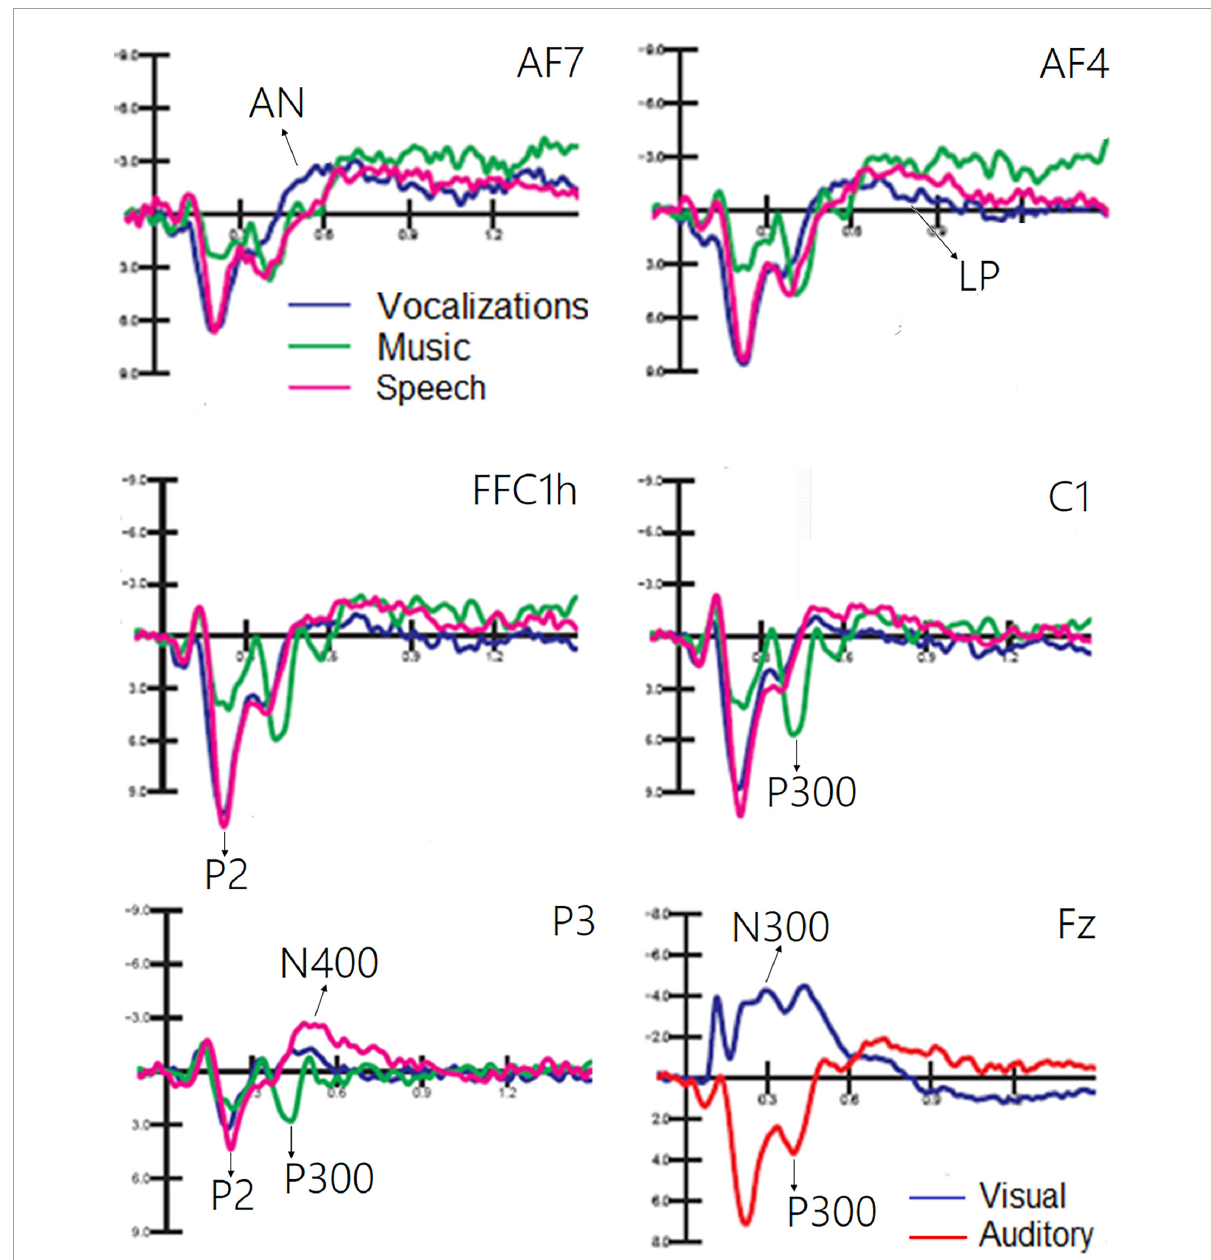
FIGURE6 Grand average ERP waveforms relative to the auditory processing of vocalizations, music, and speech. A large PN300 deflection sensitive to stimulus sensory modality (visual vs. auditory) is shown in the (bottom) right part of the